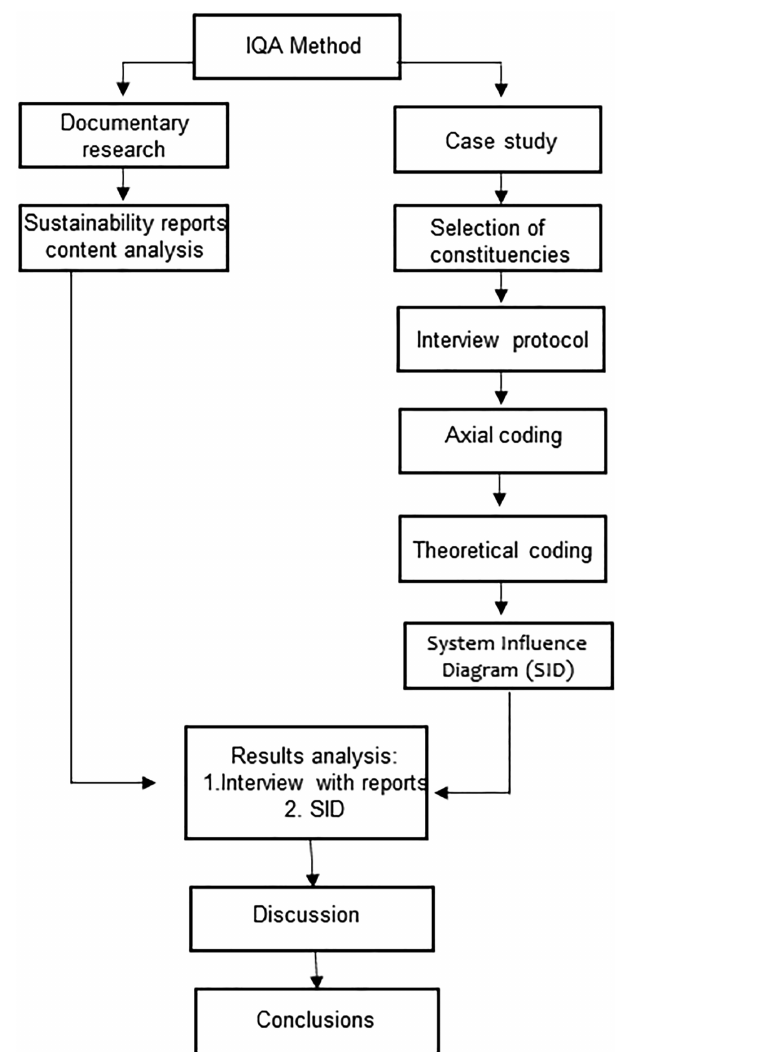
Figure 2. Research